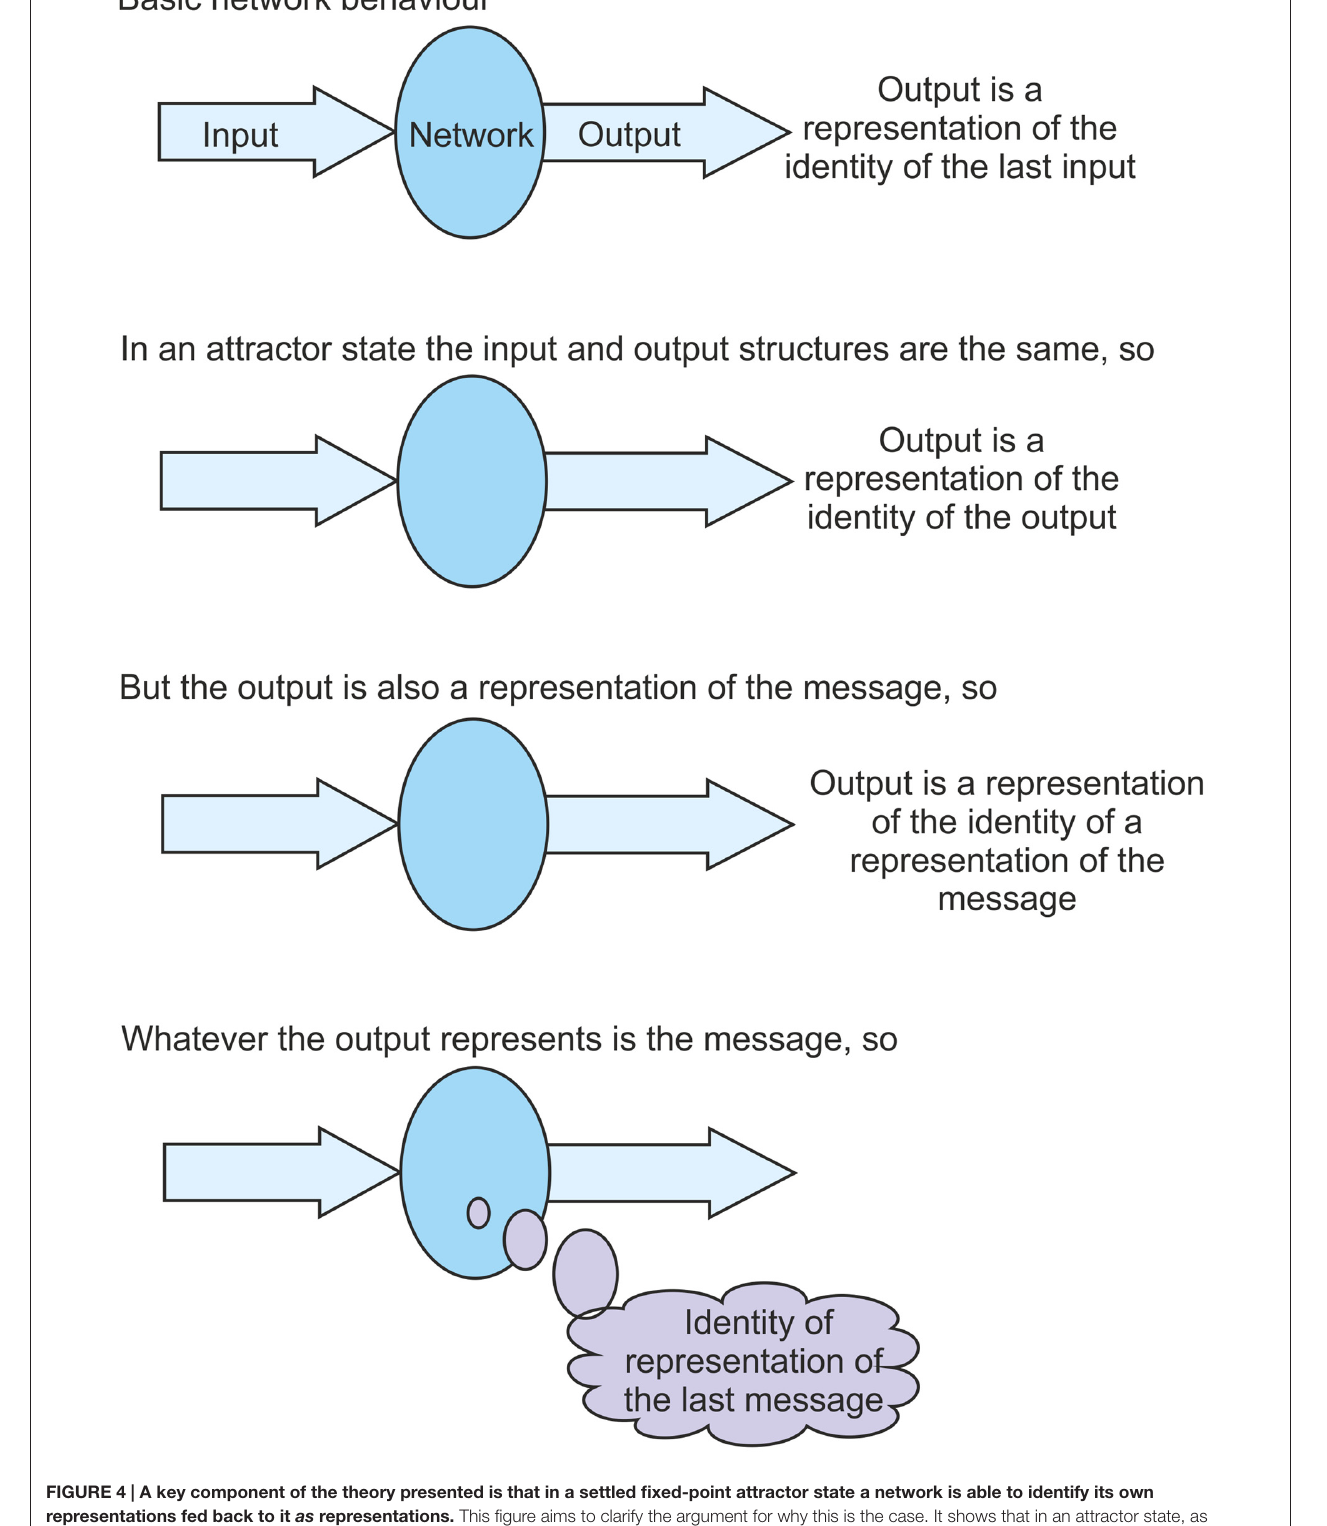
Frontiers in Systems Neuroscience |